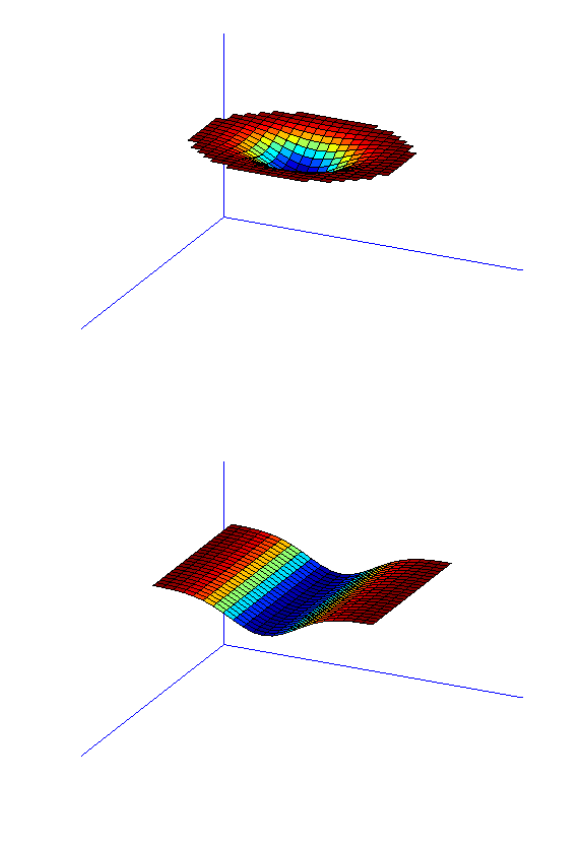
Figure 8. Prism models of circular (top) and linear (bottom) subsi-